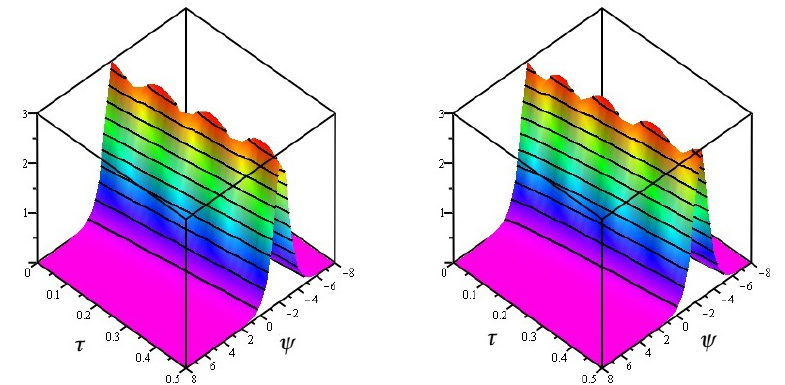
Figure 4. Exact and analytical solution of ϕ ( ψ , τ ) at (cid:118) = 1 and